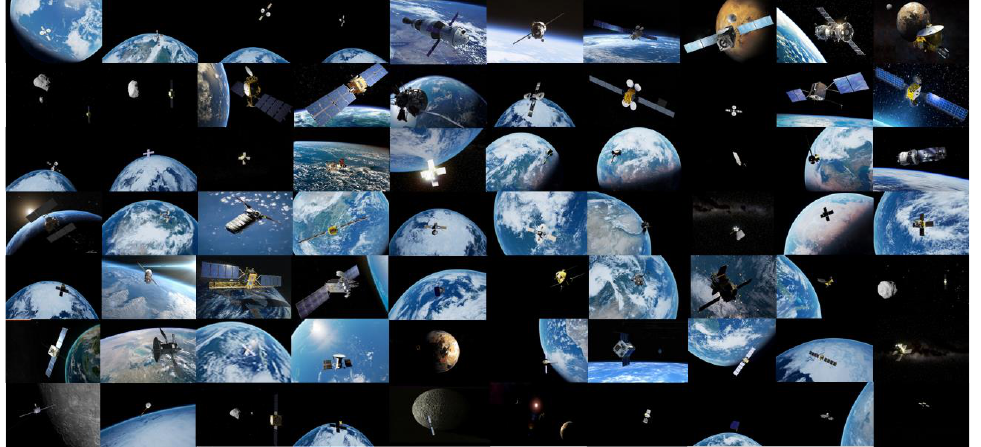
Figure 2. Several samples in the built spacecraft dataset.